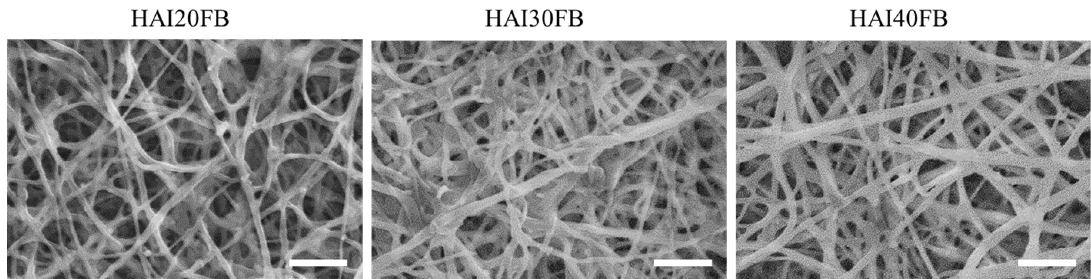
Figure 1. The SEM micrographs of HAI20FB, HAI30FB, and HAI40FB nanofibrous membranes (NFMs). Bar = 10 μ m. HAIFB nanofibers containing 20, 30 or 40% IBU become HAI20FB, HAI30FB and HAI40FB NFMs, respectively.